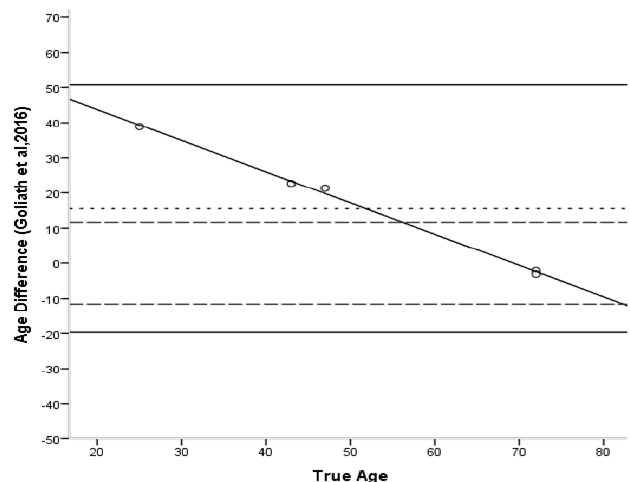
Figure 10. Bland–Altman plot for Goliath’s et al. [16] method illustrating the differences between known and estimated ages for the femora against the known age. Depicted are 95% limits of agreement (black horizontal lines), mean difference/bias (black dotted line), best fit lines and 95% confidence intervals of the SEE for each method (dashed lines). R 2 of the best fit line: 0.997.